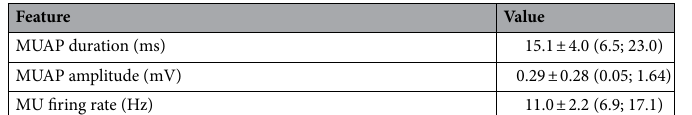
Table 1. Bioelectrical features recorded by needle-EMG are in line with the values of biceps brachii in normal healthy subjects. The features correspond to the MUAPs duration, amplitude, and the MU’s firing rate in the biceps brachii for the 64 MUs.